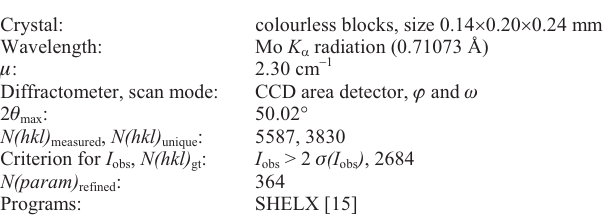
Table 1. Data collection and